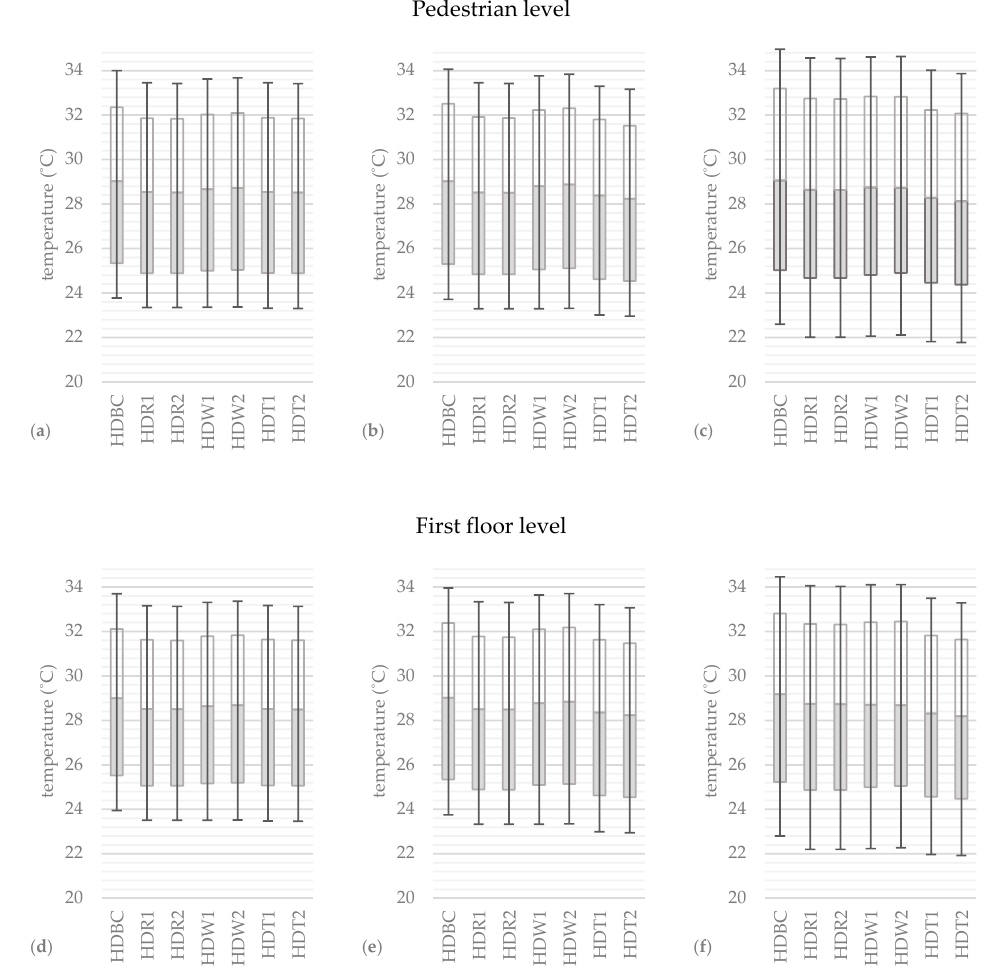
Figure 8. Air temperature in a typical building quarter during the hottest day of the year (( a ) the interior of the building quarter at 1.4 m height, ( b ) canyon with the axis perpendicular to the direction of air inflow at 1.4 m height, ( c ) canyon with the axis parallel to the direction of air inflow at 1.4 m height, ( d ) the interior of the building quarter at 5 m height, ( e ) canyon with the axis perpendicular to the direction of air inflow at 5 m height, ( f ) canyon with the axis parallel to the direction of air inflow at 5 m height).